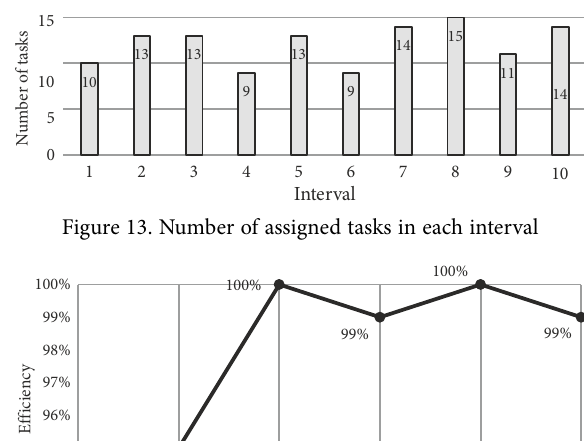
Figure 12. Number of assigned tasks for each member